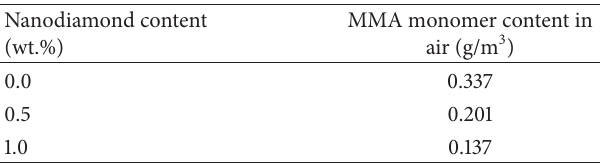
Table 2: Content of MMA monomers in air for the base materials prepared with different nanodiamond